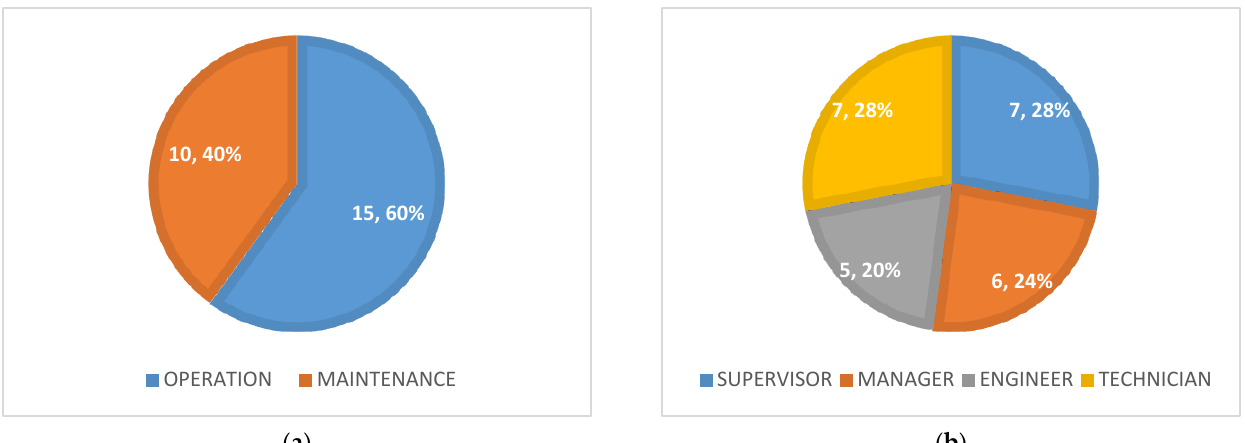
Figure 5. ( a ) Professionals ’ department. ( b ) Professionals ’ position/function.